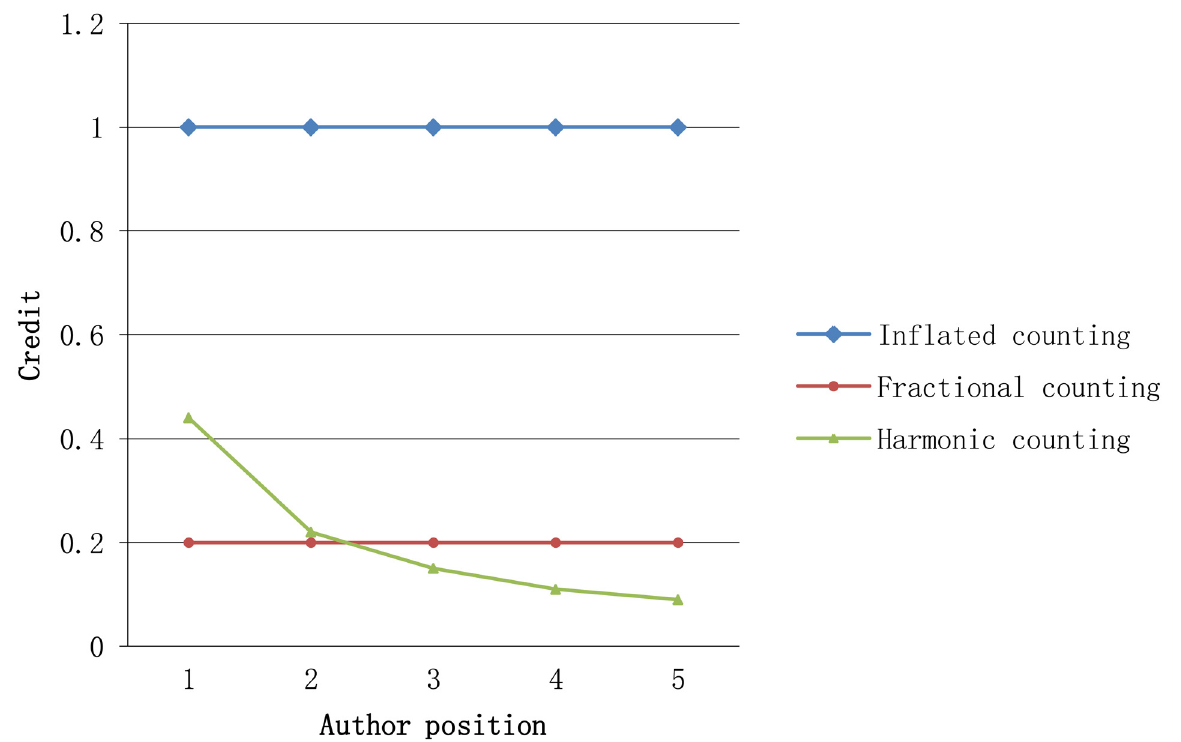
Fig 1. The representative credit-assignment schemas ’ distribution.